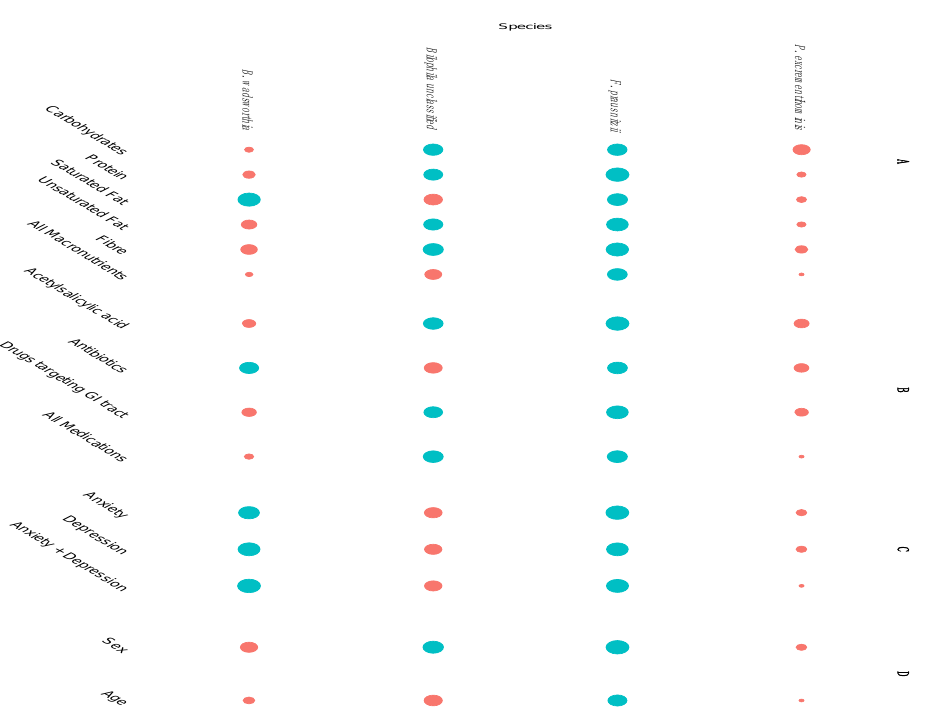
Figure 5. Significance of difference between older adults and senior orienteers after correction for macronutrients, psychological distress, and medication variables. Corrected bacterial composition values were compared between groups for each species and false discovery rates (FDRs) calculated. The dots represent negative log10 p-values belonging to respective species, where blue denotes significance and red denotes non-significance, with a significance threshold at FDR < 5%. A Results for models with a single macronutrient variable and with all macronutrient variables in a multi-variable model. B Results for models with single medication variables and with all variables in a multi-variable model. C Results for models regarding anxiety and depression separately with single Hospital Anxiety and Depression Scale (HADS) variables and with both HADS variables in a multi-variable model. D Results for models with sex and age.